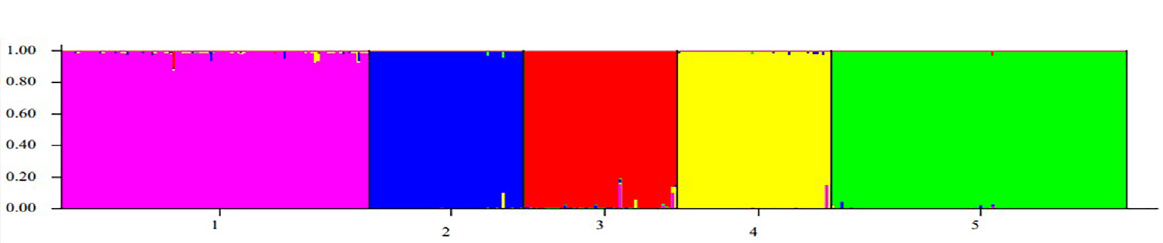
Figure 10. Representation of the populations of Guadua aff. chaparensis and G. aff. lynnclarkiae using the Structure 2.3.4 program. Each color represents a population, Pink: P1; Blue: P2; Red: P3; Yellow: P4 and Green: P5 ( G . aff. lynnclarkiae